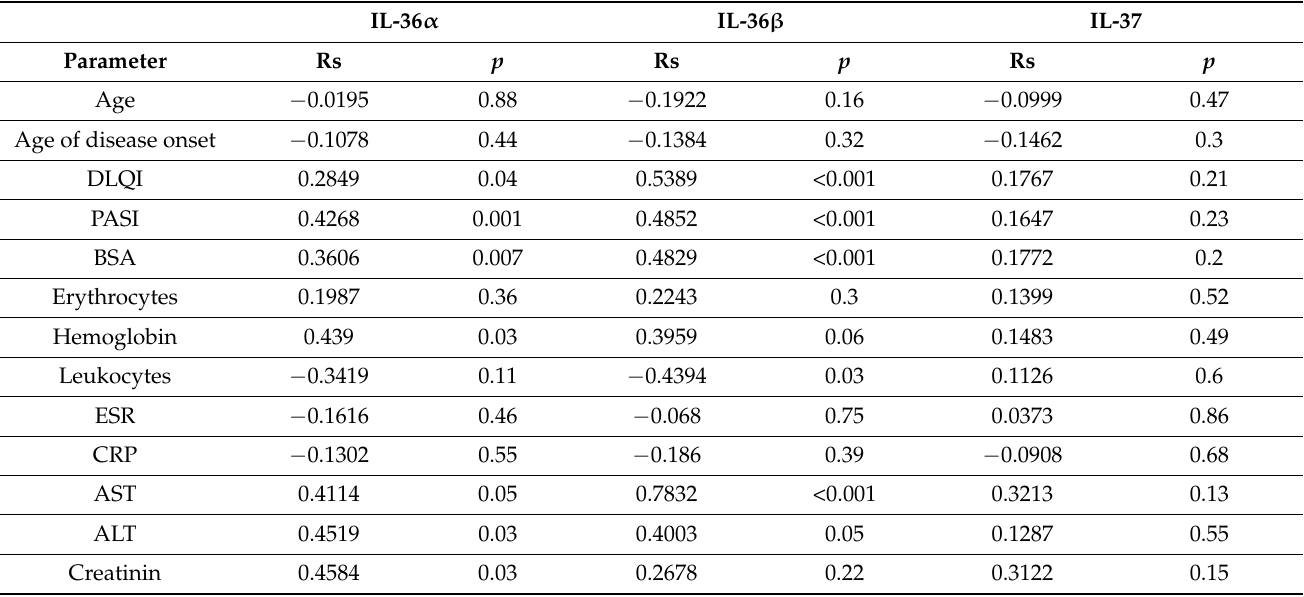
Figure 3. Plasma concentrations of IL-37 in patients with psoriasis and control group. * p < 0.001.